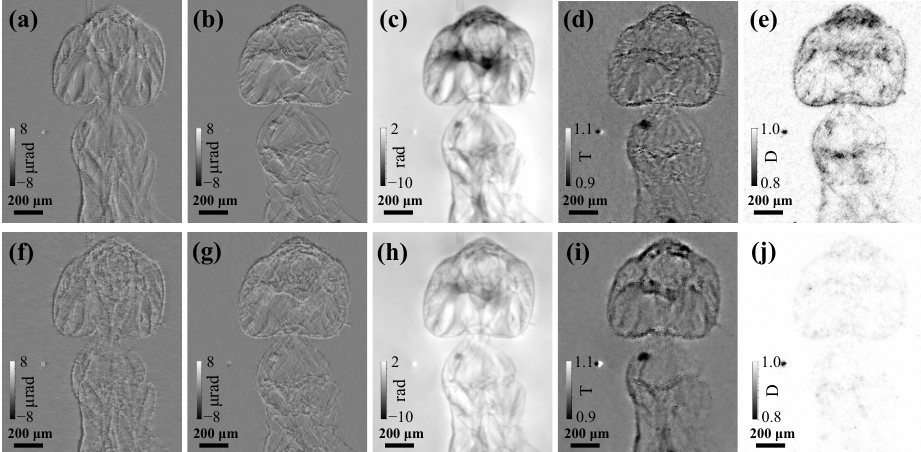
Figure 2. Reconstructed ( a , f ) horizontal differential phase ( φ x ), ( b , g ) vertical differential phase ( φ y ), ( c , h ) phase ( φ ), ( d , i ) transmission ( T ), and ( e , j ) dark-field ( D ) images using (top row figures a – e ) scanning CMMI with N = 10 scan positions and (bottom row figures f – j ) single-shot CMMI with N = 1 and j = 0. Note that the bright spot next to the ant comes from defect of the